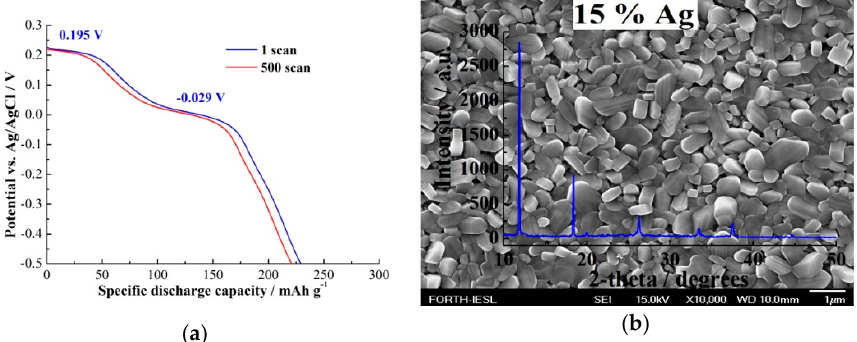
Figure 6. ( a ) The chronopotentiometry curves of the V 2 O 5 samples at 450 ◦ C via AACVD at atmospheric pressure for 15% Ag loading and annealed at 600 ◦ C for 3 h under a specific current of 400 mA g − 1 and potential ranging from + 0.3 to − 0.5 V for the 1st and the 500th scan. ( b ) XRD overlapped over the FE-SEM image of the sample.